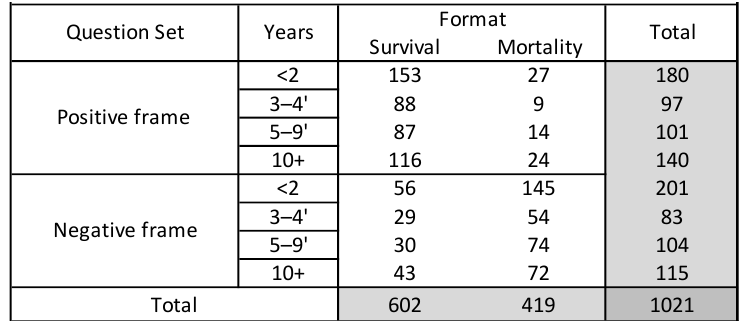
Figure 11: Respondent Total by Years in Home